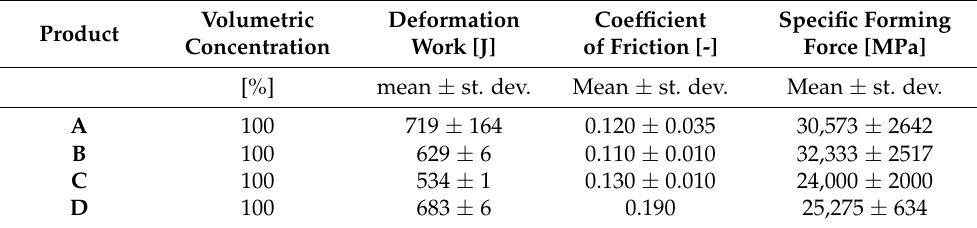
Table 4. An overview of the measured parameters for the tested polymers A – D .